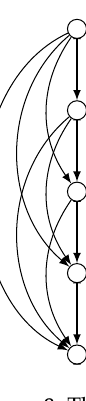
Figure 8. The DAG for the partial order game with five players illustrating Proposition 4. Figure 9. The DAG for the par- tial order game with five players illustrating Proposition 4.